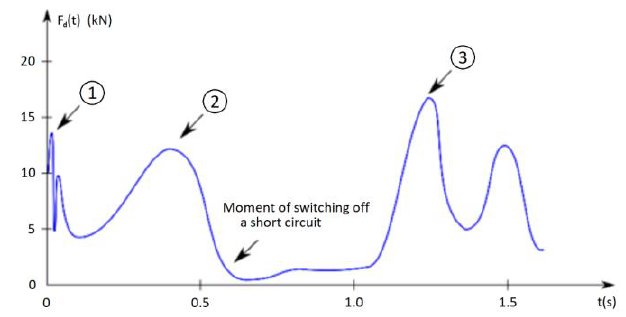
Figure 3. Diagram of the values of forces generated during a short circuit [9].